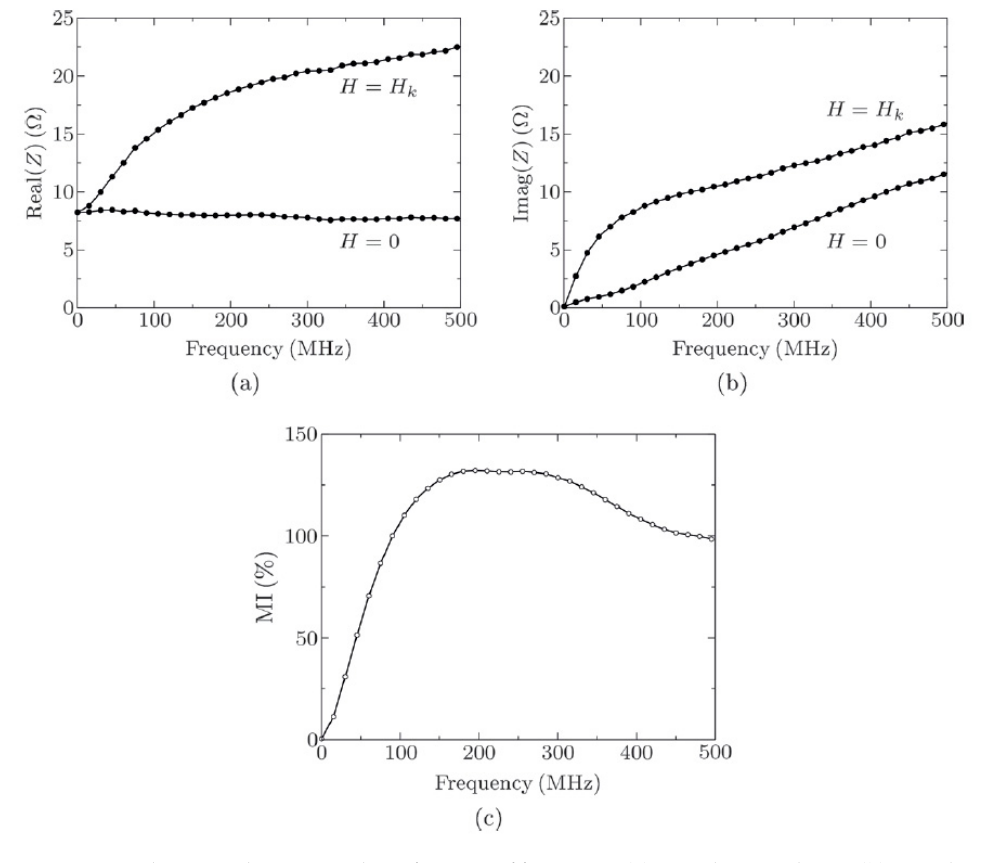
Figure 5. Impedance results measured as a function of frequency. ( a ) Impedance real part. ( b ) Impedance imaginary part. ( c ) Magneto-impedance ratio. Reprinted with permission from [9], under the Creative Commons Attribution (CC BY 3.0) license.